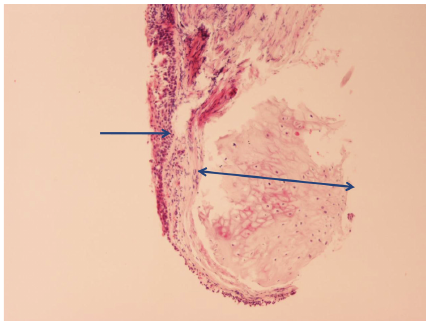
Figure 4: Histopathologic image of patient’s bronchial wall showing presence of cartilaginous tissue in submucosa, compatible with tracheobronchopathia osteochondroplastica (Hematoxylin-Eosin stain ×